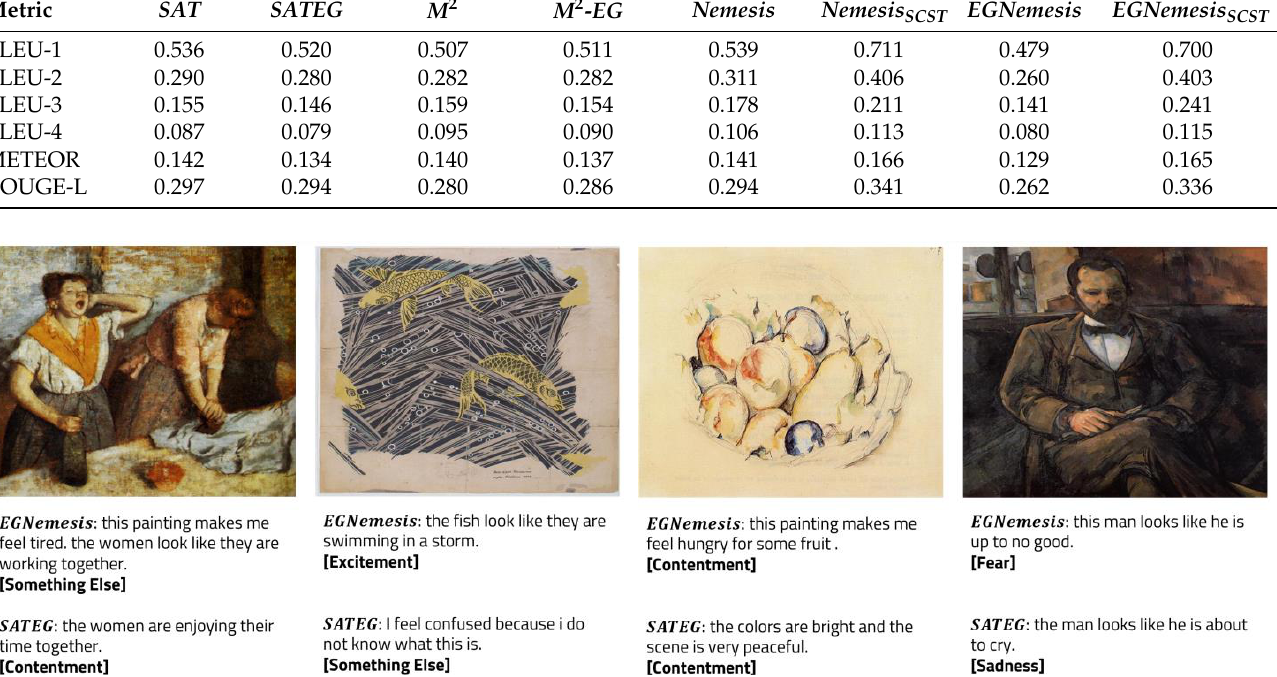
Figure 5. A comparison between the examples of generated captions by EGNemesis and SATEG models along with the emotional class extracted by the image-to-emotion classifier, which has been utilized in the emotional grounding process. It can be observed that the generated utterances by EGNemesis appear to be more abstract, human-like, and emotionally